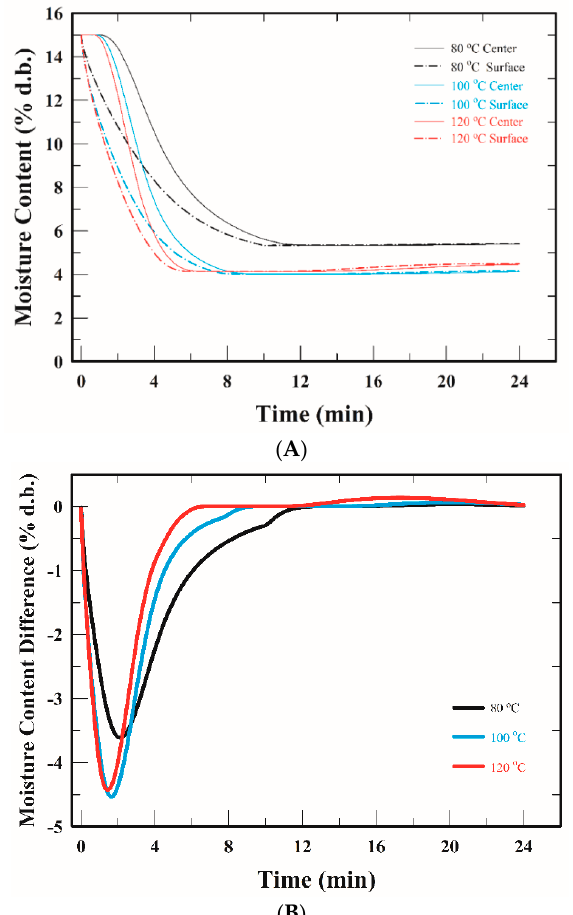
Figure 10. Simulated profiles of the moisture content (MC) distribution ( A ) and the MC difference ( B ) of WG during drying at different set temperature in the FBD. Solid lines represent the WG center; dash-dot lines represent the WG surface.